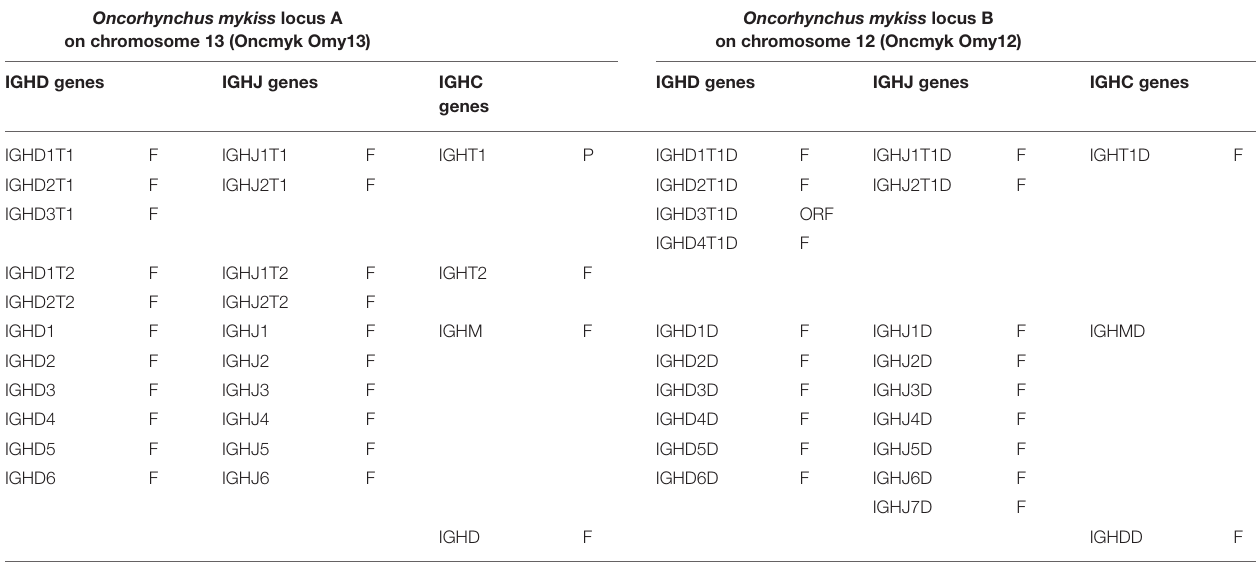
TABLE 3 | Rainbow trout ( Oncorhynchus mykiss ) IGH constant C genes and associated D and J genes. Oncorhynchus mykiss locus A on chromosome 13 (Oncmyk